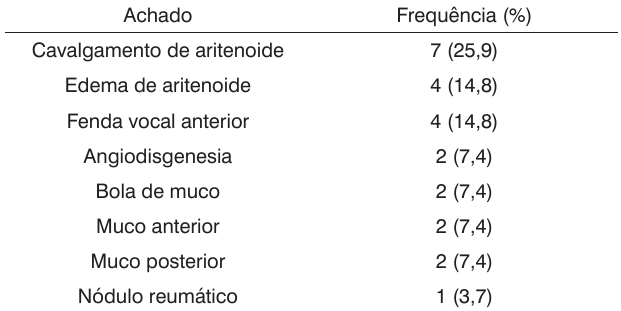
Tabela 3. Achados